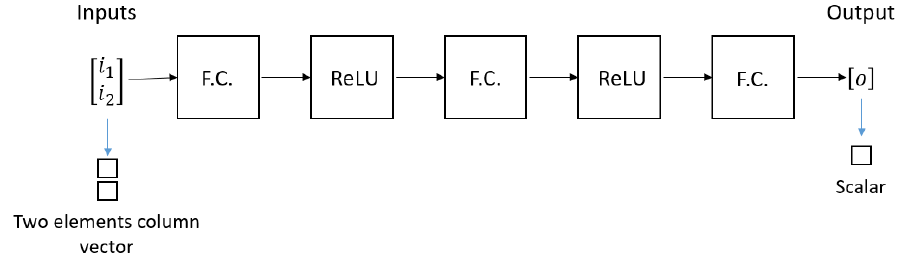
Figure 3. Representation of the network under study.